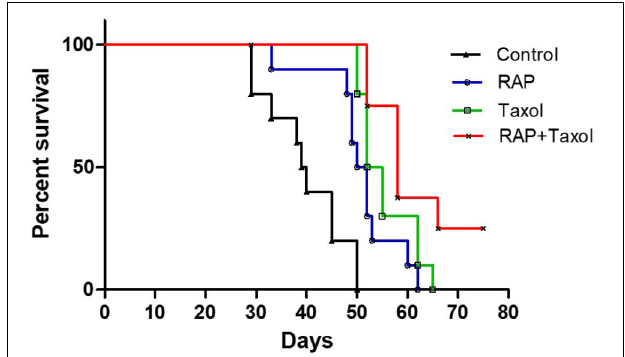
FIGURE 1 | Long time survival of 4T1 breast tumor-bearing mice treated with RAP with/without Taxol.